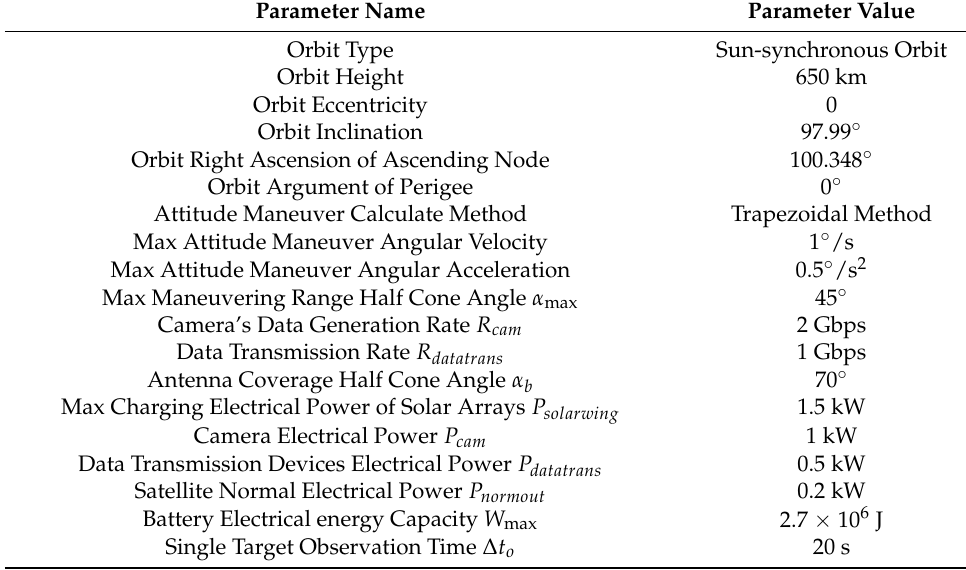
Table 2. The satellite